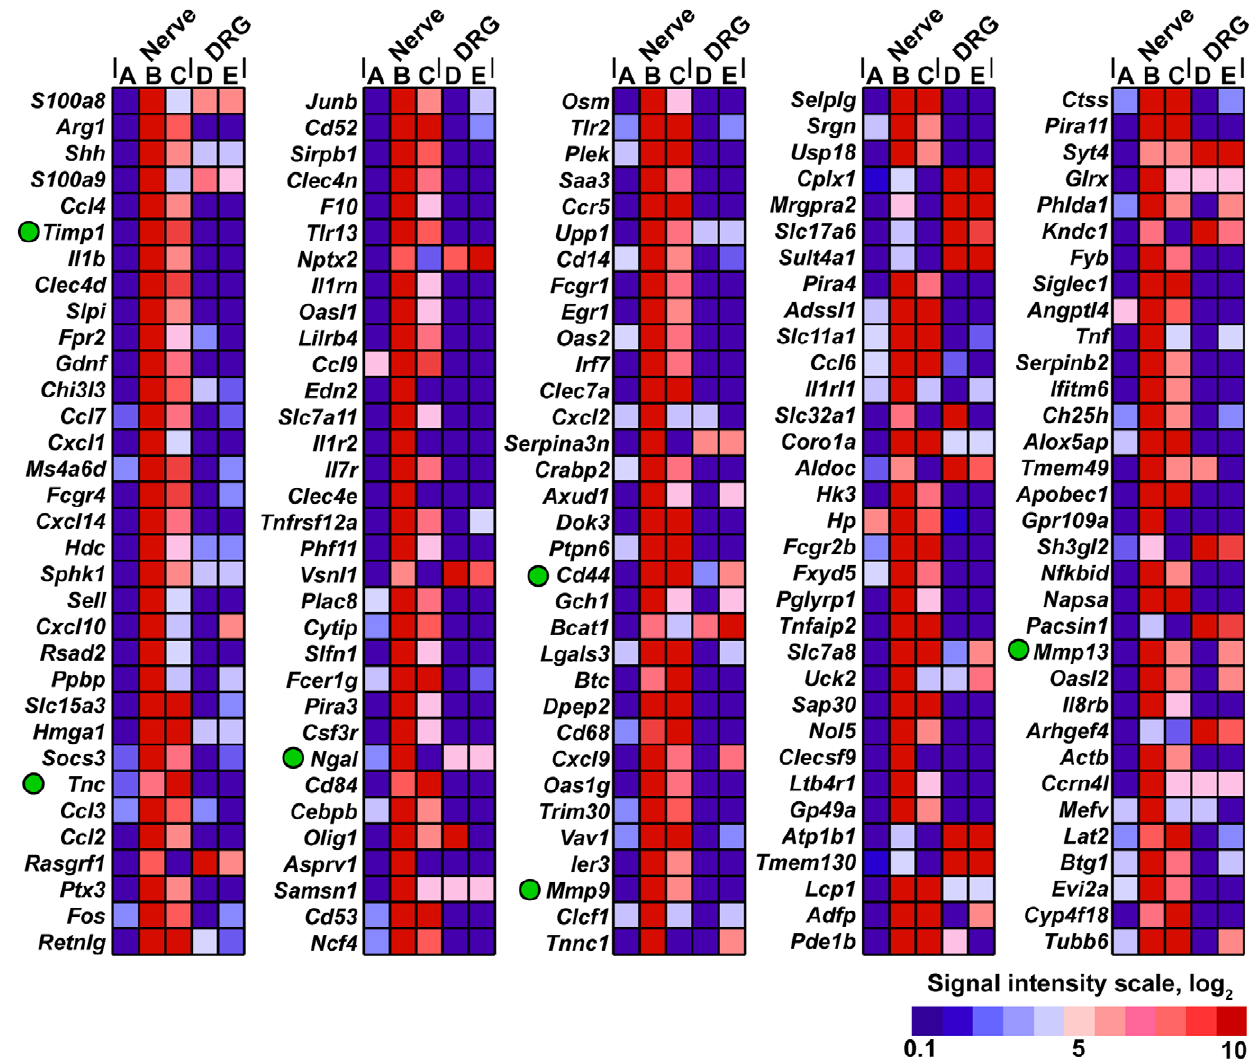
Figure 1. Heatmap of the genome-wide transcriptional profiling data of the murine sciatic nerve and the corresponding L4/5 DRG from the same animals. Red and blue correspond to the high and the low expression levels, respectively. Color map inset shows the signal intensity scale. Only the genes with the B:A ratio . 4 are shown in a descending order. A, sham nerve; B, nerve day 1 post-transection; C, nerve day 5 post-transection; D, DRG corresponding to the sham-operated nerve; E, DRG corresponding to day 5 post-transection. The green dots point to TIMP- 1, TNC, NGAL, CD44, and MMP-9 induced in the injured nerve, and MMP-13 in the DRG. DRG, dorsal root ganglia.